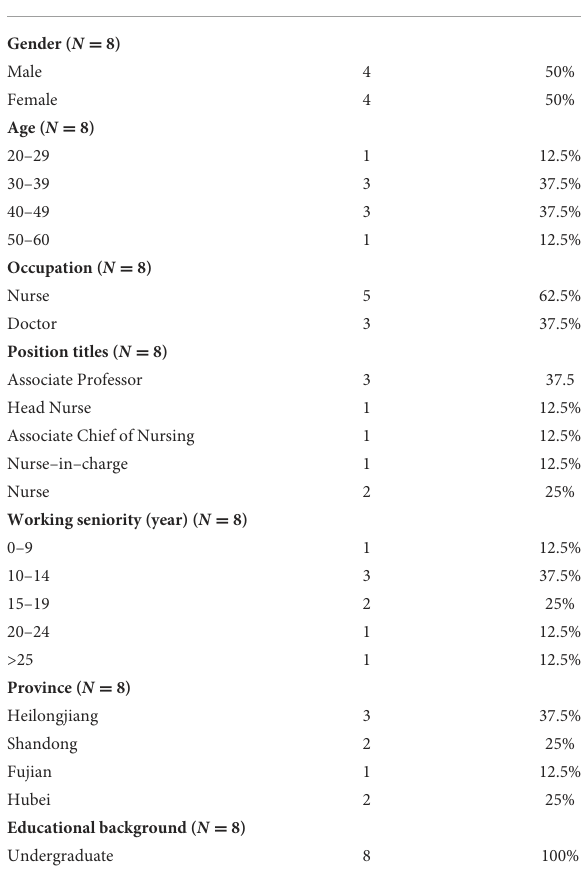
TABLE 1 Demographic characteristics of